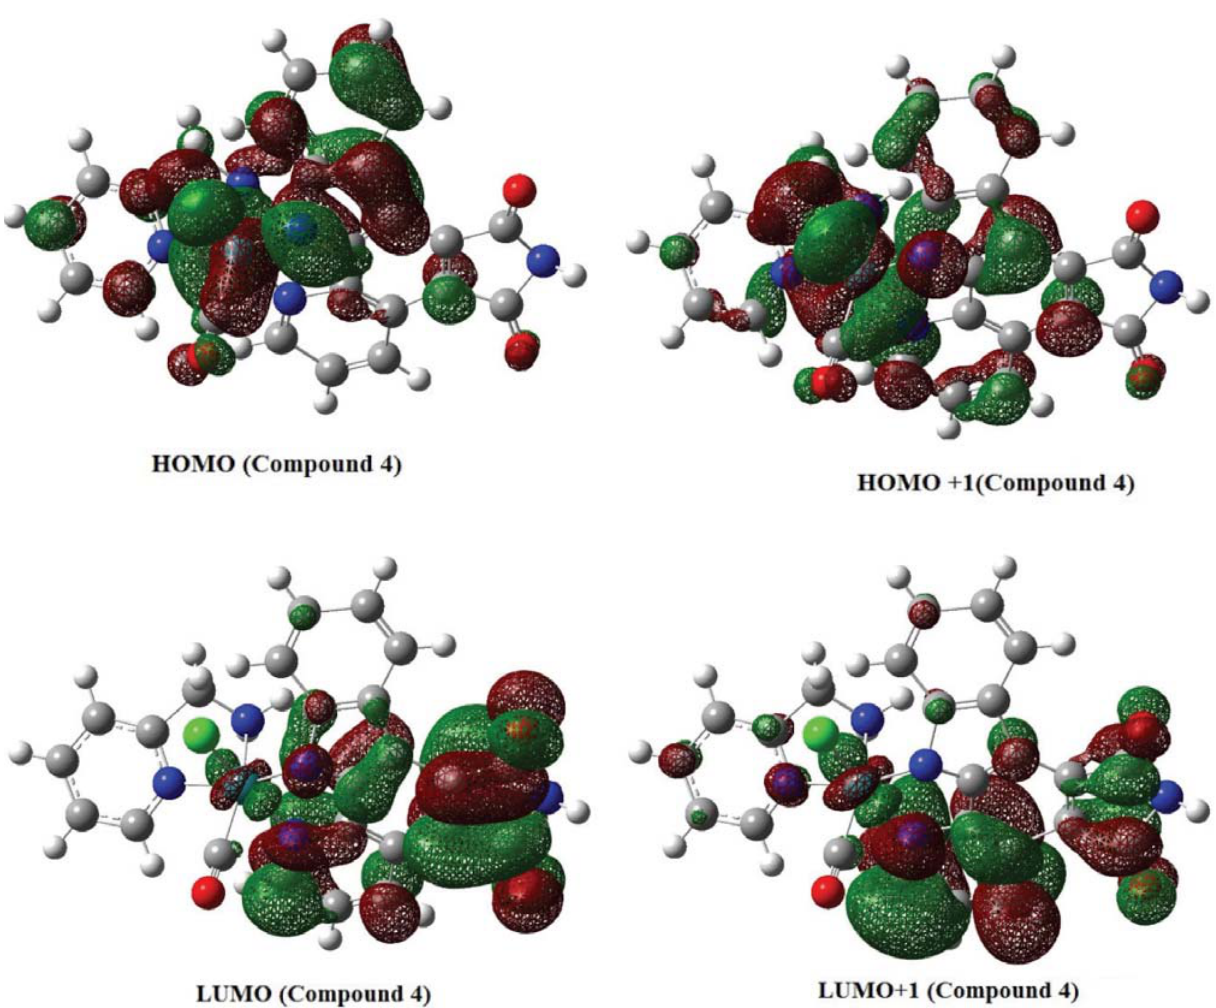
Figure 7. HOMO and LUMO molecular orbitals of the staurosporine complex ( 4 ) using the LANL2DZ method.